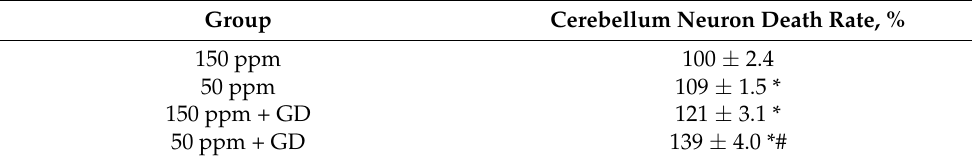
Table 1. The death rate of cultured cerebellum neurons under the condition of glucose deprivation in mediums with different deuterium